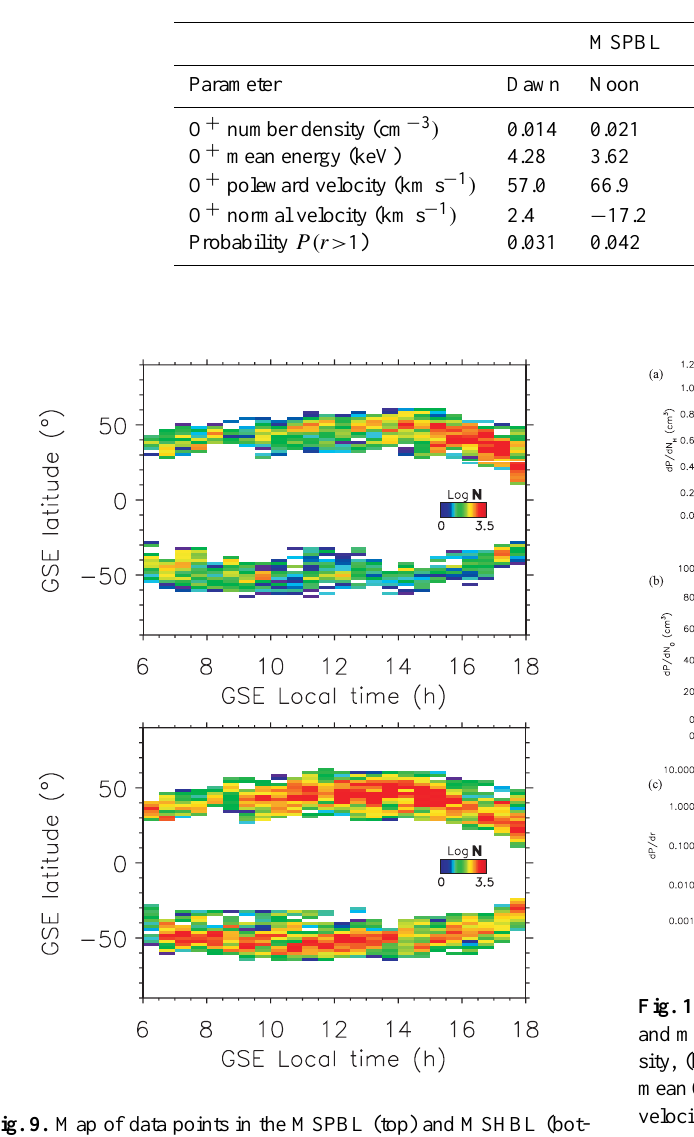
Fig. 9. Map of data points in the MSPBL (top) and MSHBL (bot- tom) from all crossings between December 2000 and May 2003 with SC1 and SC3 as a function of GSE local time and latitude. The color code is in Log of the number of samples per bin.